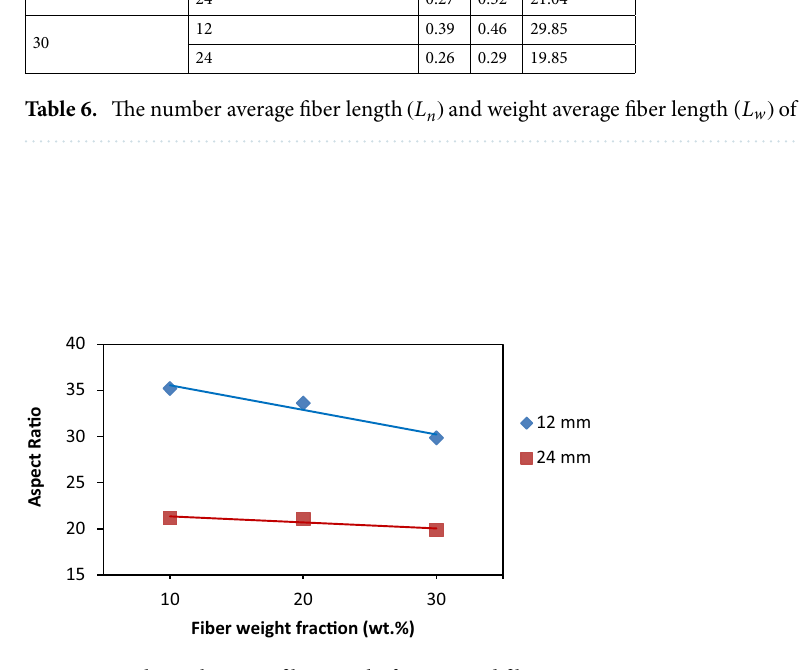
Figure 4. Relation between fiber weight fraction and fiber aspect